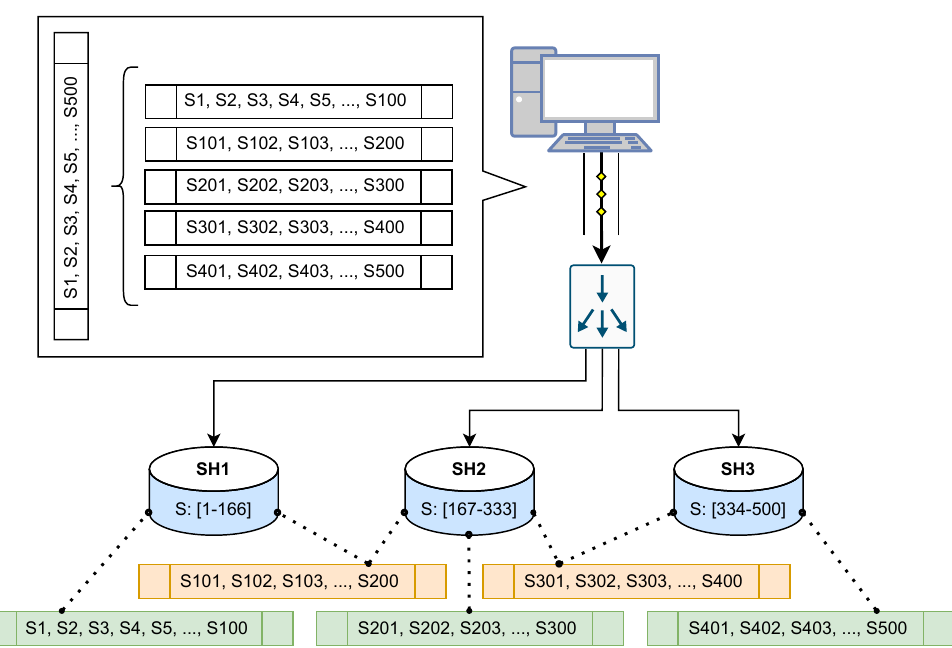
Figure 16. Briefed data ingestion procedure under a setup following 1:5 × 100 approximation with three ingestion shards, each holding one third of the